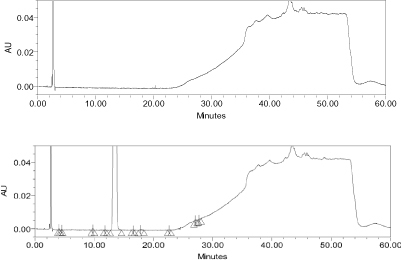
Reference chromatogram of 1% H2O2 (blank) and degradation obtained after testing with 1% H2O2